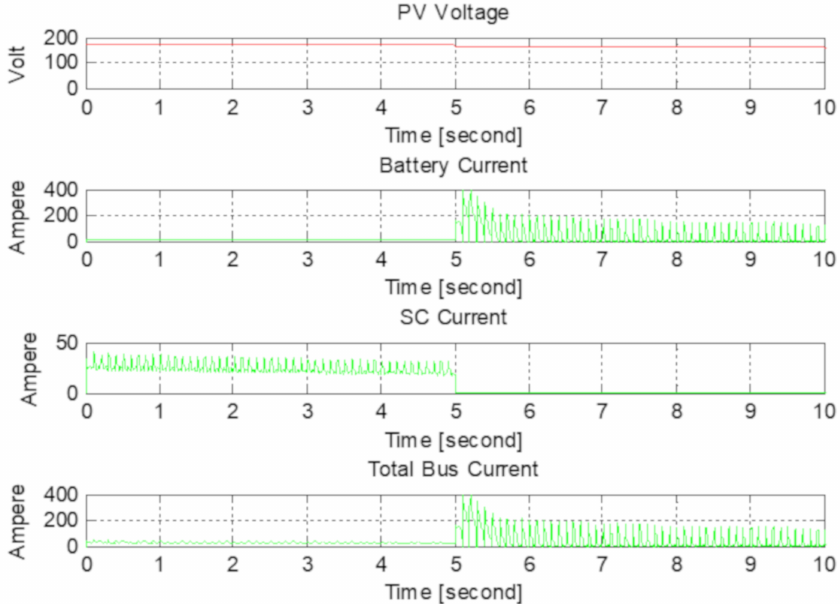
Figure 15. The simulation results of current variations for two di ff erent level PV